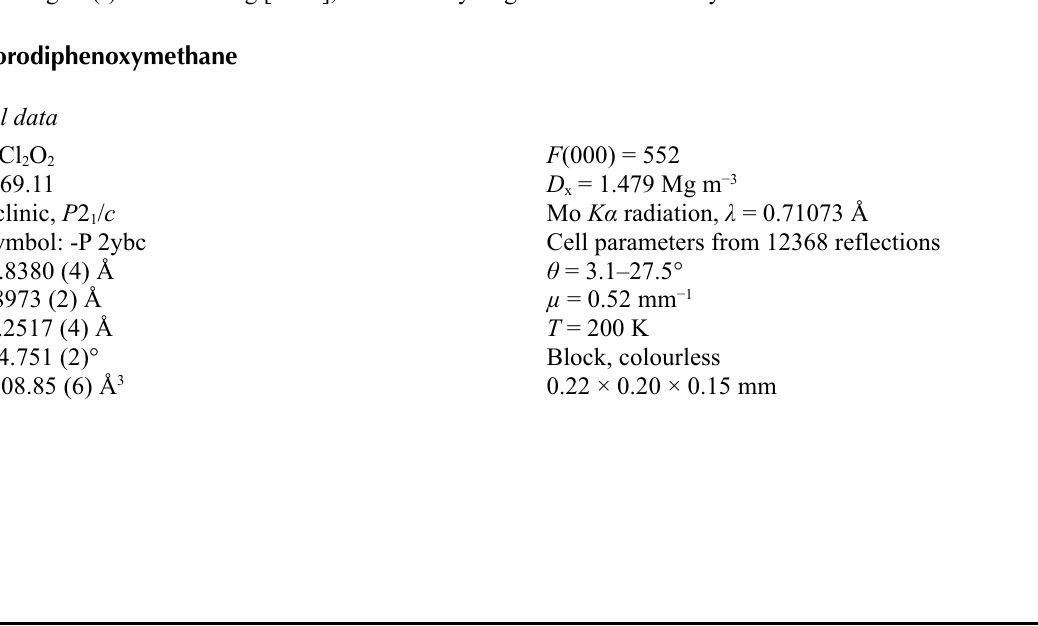
The packing of (I) viewed along [0 1 0], C—H···O hydrogen bonds drawn as yellow bars.